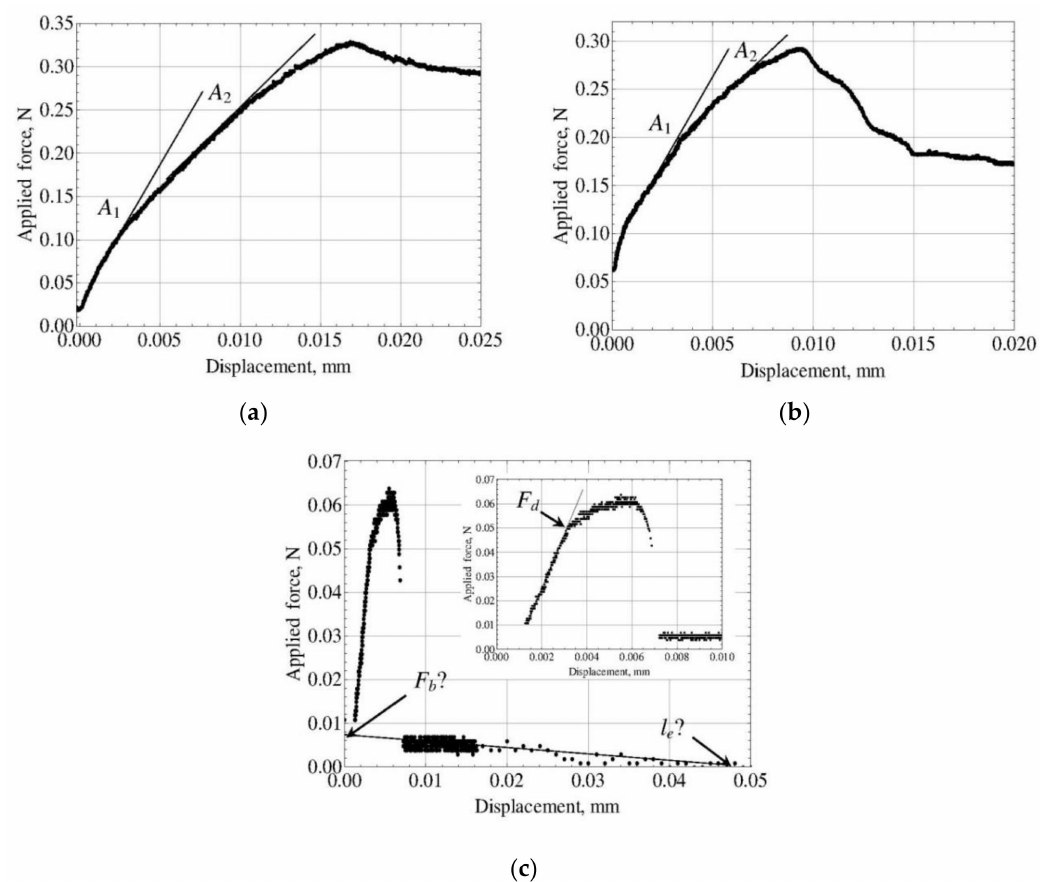
Figure 6. The initial parts of experimental force–displacement curves. ( a ) glass fiber–PP matrix, l e = 629 µ m; ( b ) PVA fiber–concrete matrix, l e = 1921 µ m; ( c ) carbon fiber (CF2)–H135 epoxy matrix, l e = 47 µ m (for this specimen, the full force–displacement curve is also